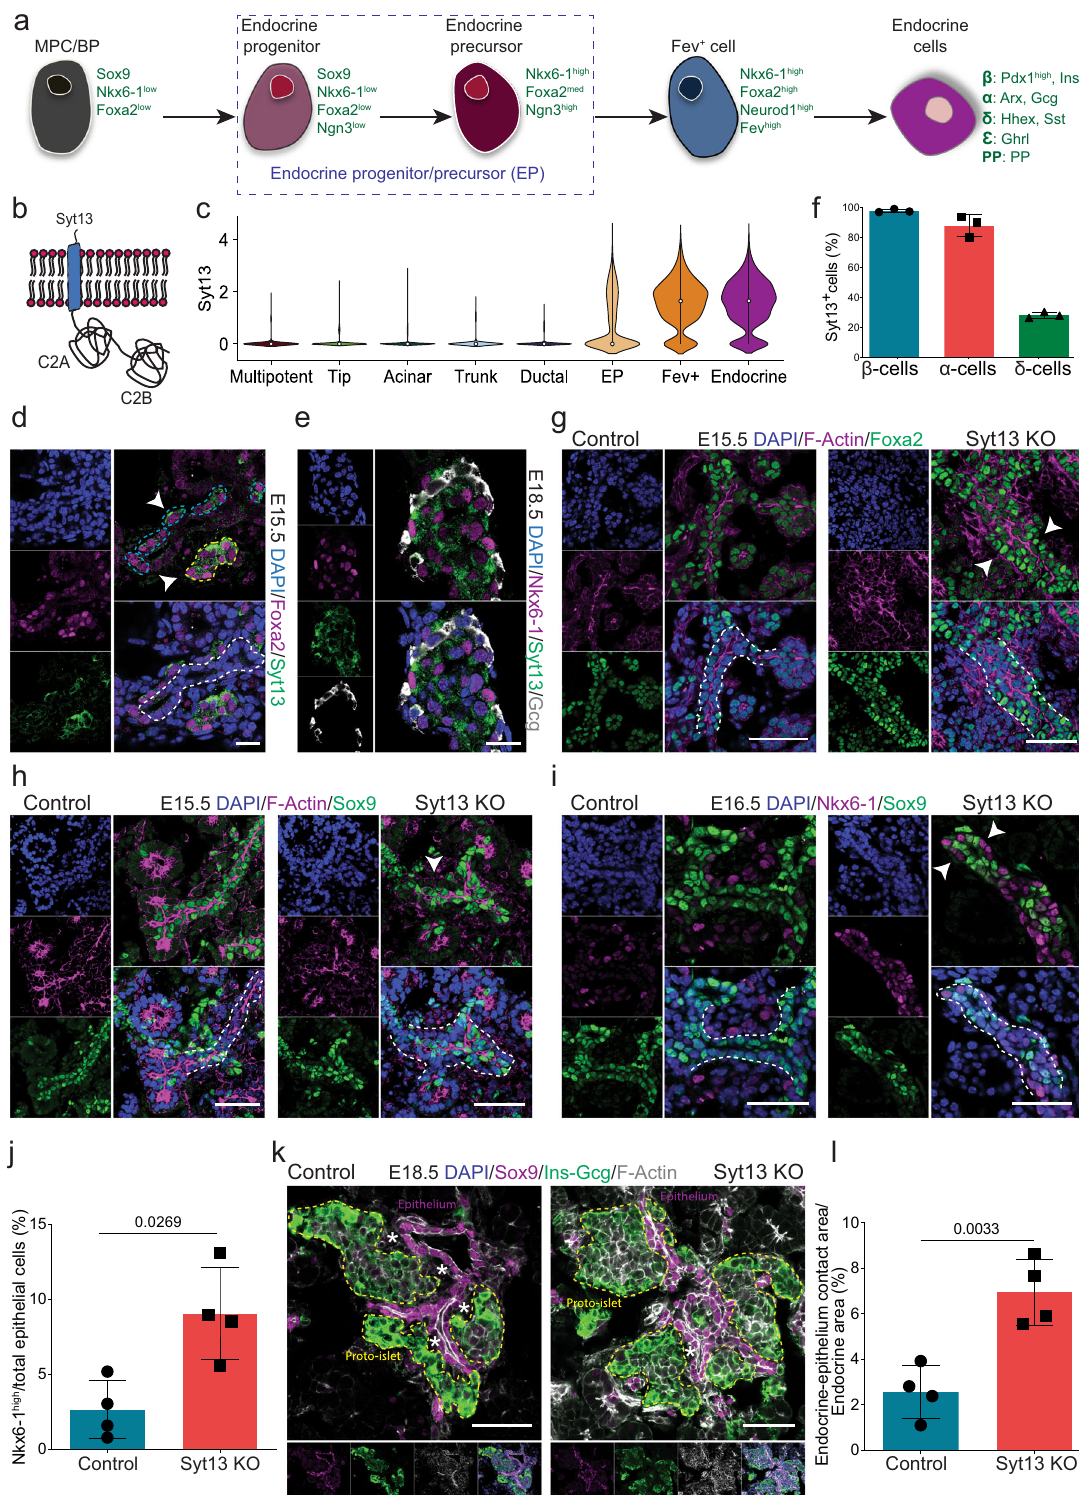
precursors (Ngn3 high ) 1 . The Ngn3 high precursors give rise to regulate glucose homeostasis. How endocrine lineage seg- different endocrine cell types via a transient intermediate cell regation is interlinked with morphogenetic programs is not population expressing the TF fi fth ewing variant protein (Fev) 2 well understood. During endocrinogenesis a subset of multi-/ (Fig. 1a). During stepwise lineage differentiation and morpho- bipotent cells in the epithelium gradually express the transcrip- genesis endocrine cells egress from the ductal epithelium (also tion factor (TF) Neurogenin 3 (Neurog3; hereafter called Ngn3) known as endocrine cell delamination) and cluster into proto- to sequentially generate endocrine progenitors (Ngn3 low ) and islets 3 – 5 . After induction of Ngn3 endocrine